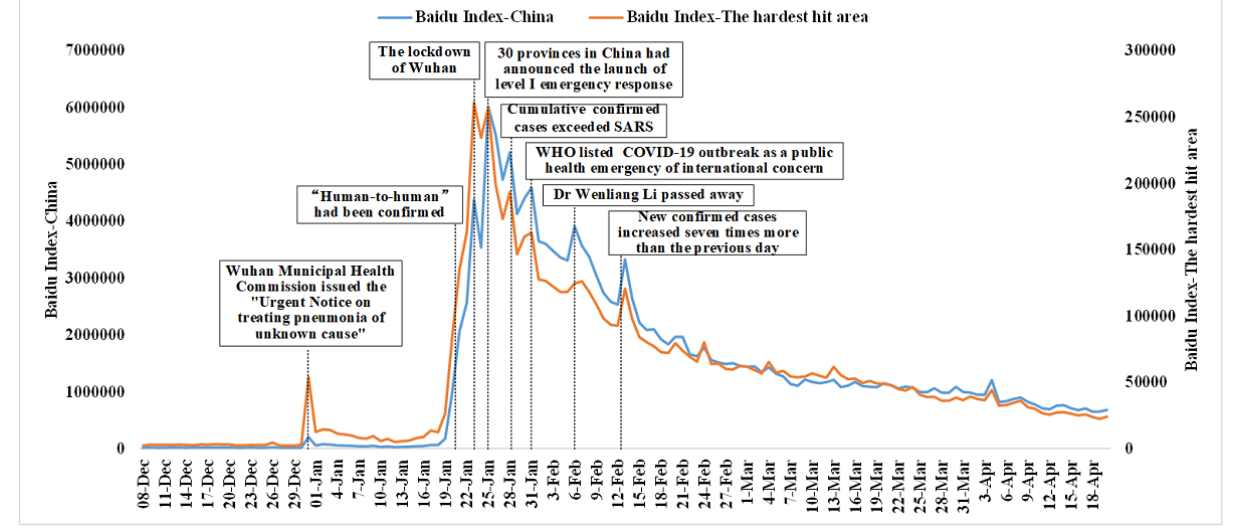
Figure 2. The changing trend of the Baidu Index of COVID-19 in China from January 2 to April 20, 2020. WHO: World Health